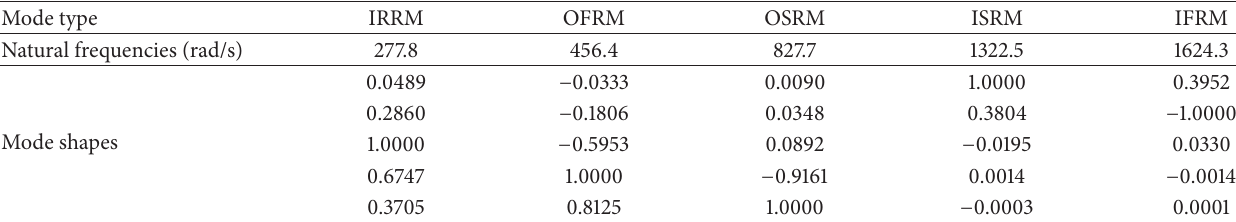
Table 3: Modal frequencies and modal shapes of EIMG